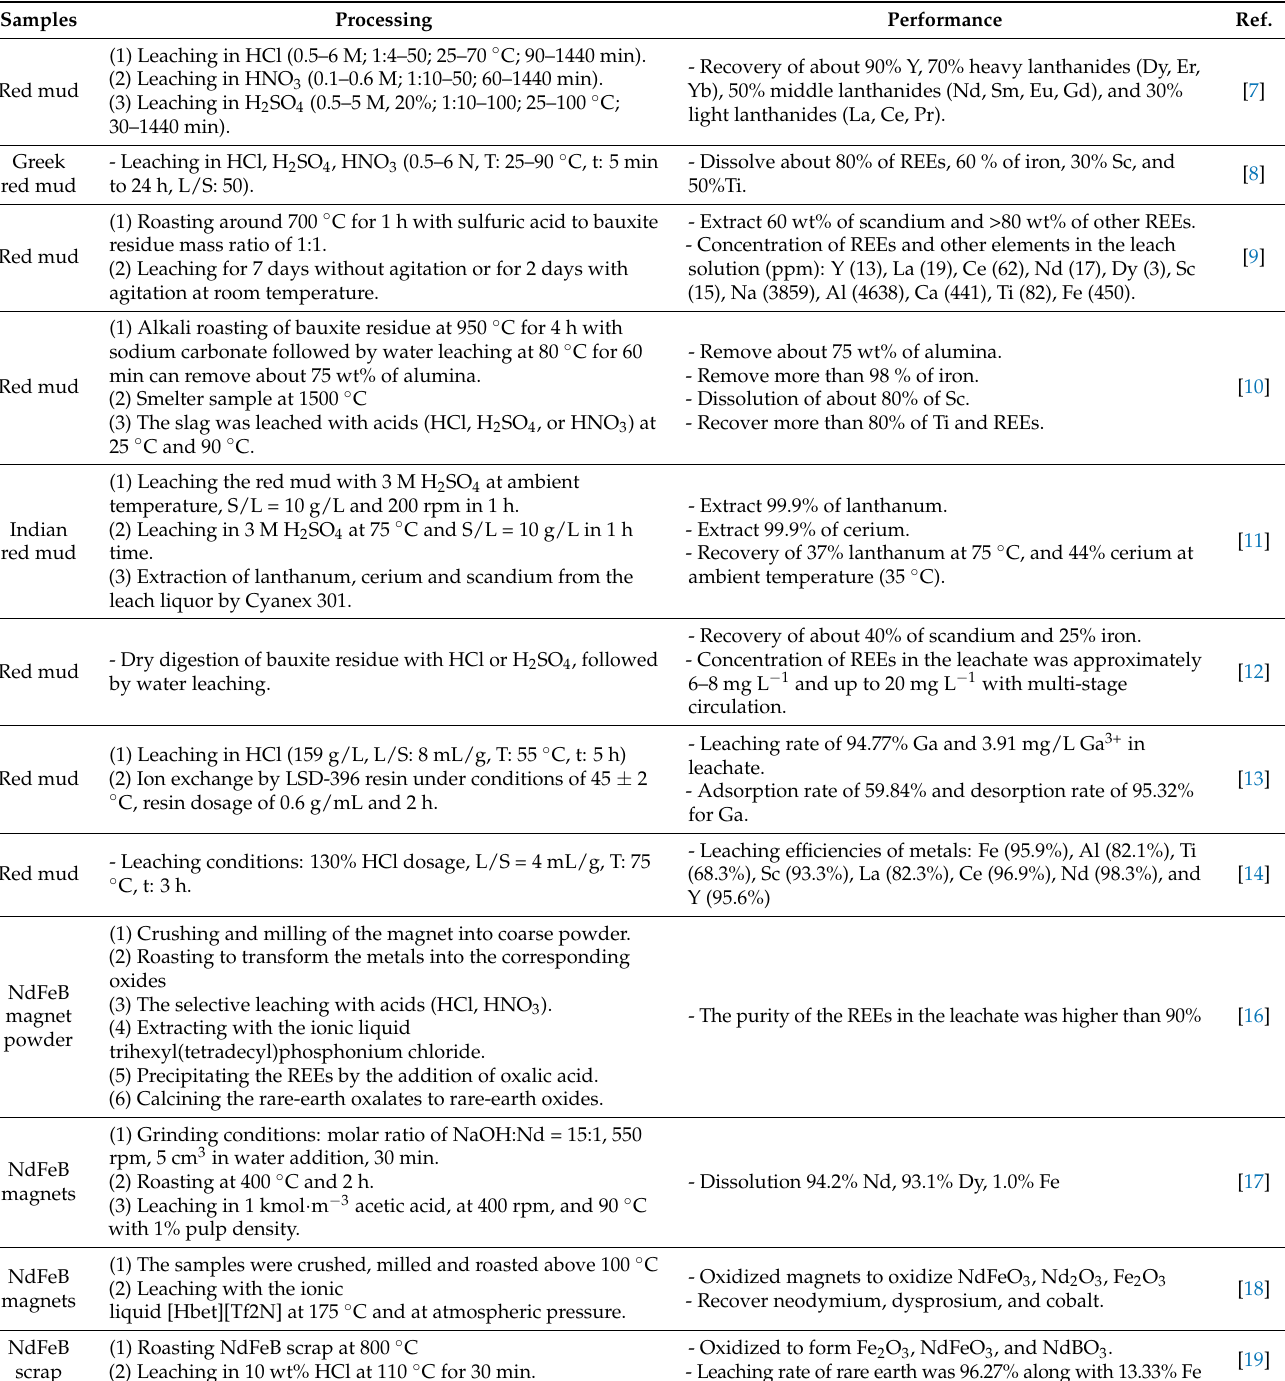
Table 1. Processes for the recovery of Ga and REE from red mud and NdFeB